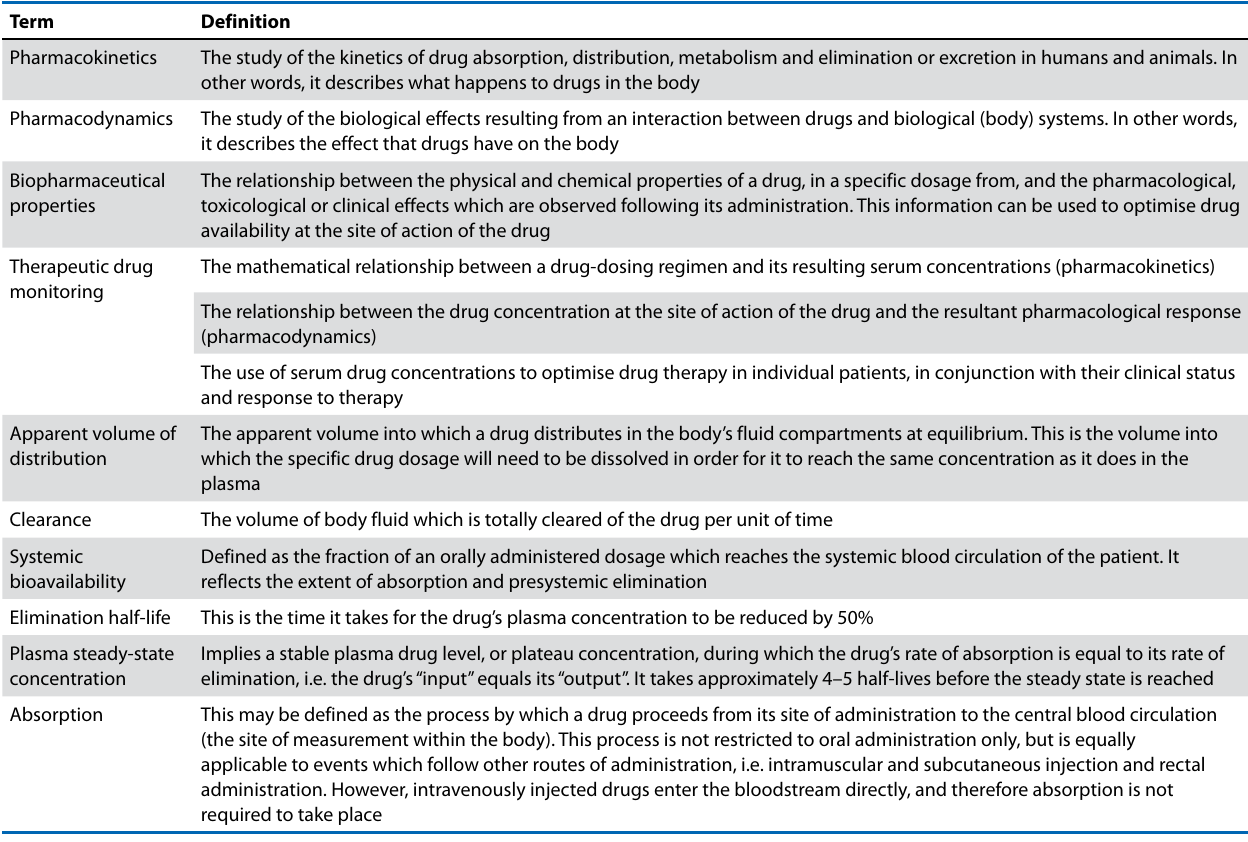
Figure 1: The vulnerability of the unborn child and neonate to drug therapy Table 1: Basic pharmacokinetic and pharmacodynamic